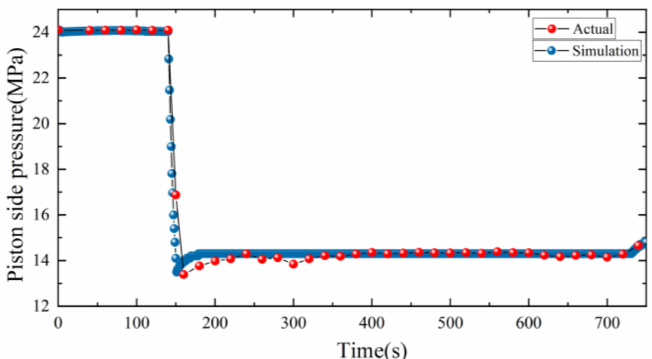
Figure 14. Piston side pressure when lowering.